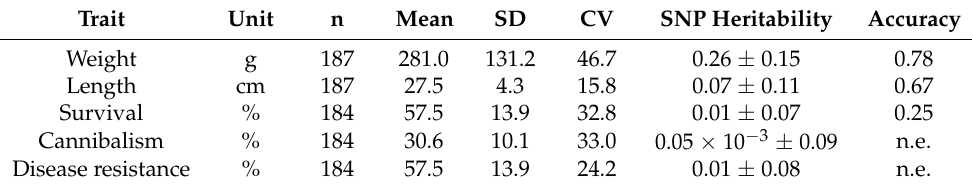
Table 1. Number of observations (n), mean, standard deviation (SD), coefficient of variation (CV, %), single nucleotide polymorphism (SNP) heritability, and accuracy of genomic prediction for traits